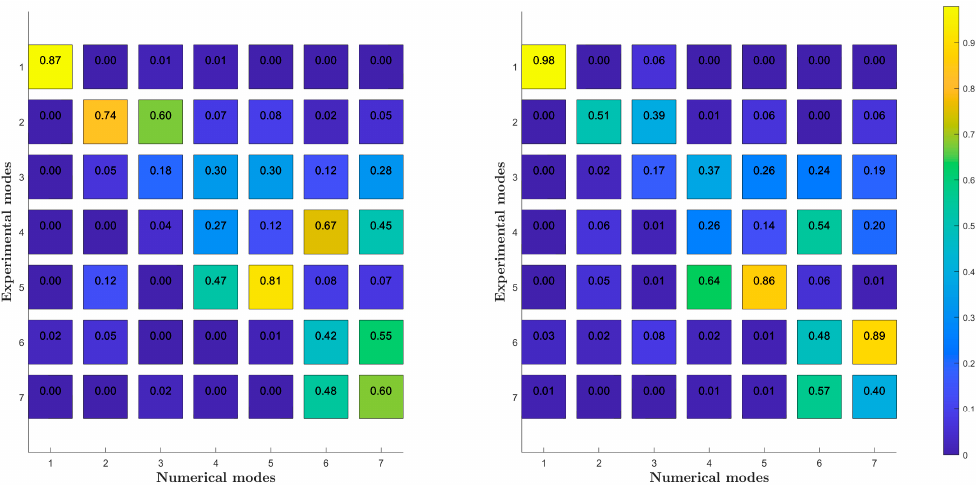
Figure 11. CROSS-MAC matrices for the stick model ( left ) and the hybrid improved FE model ( right ) vs. the GVT results in the case of tip masses in the rear